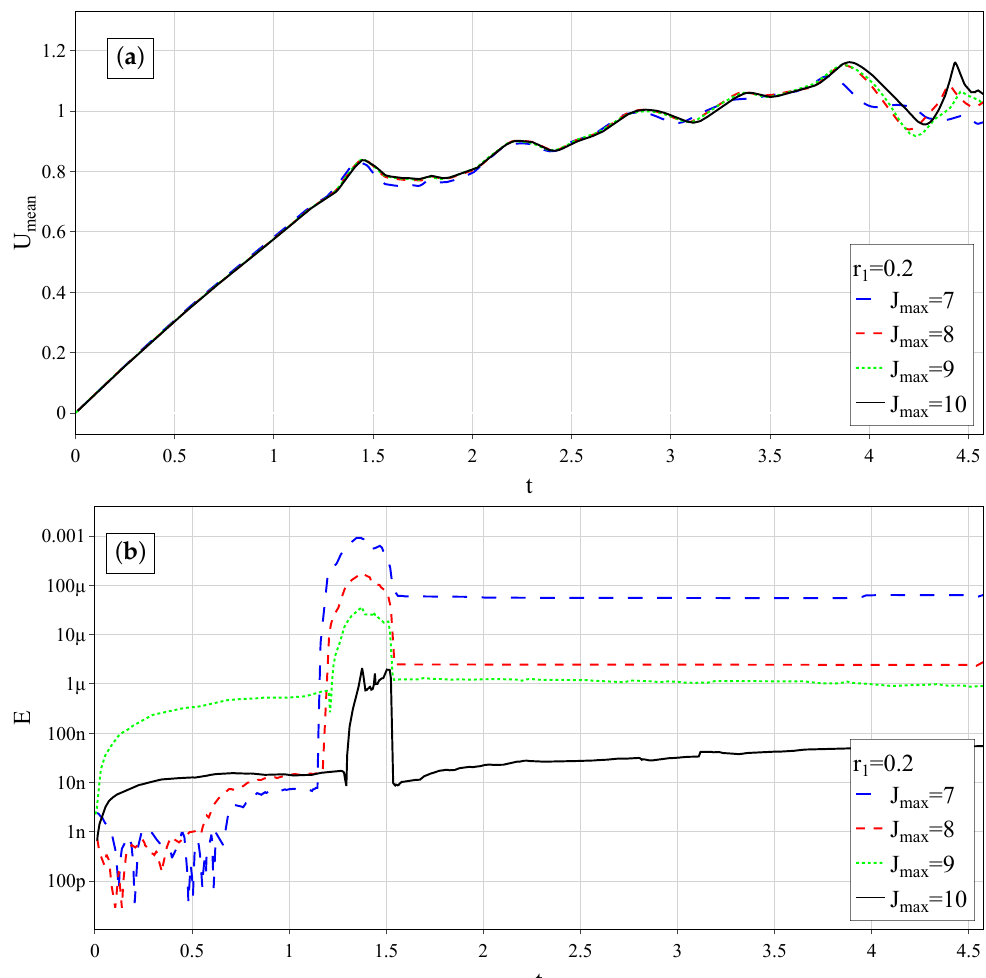
Figure 11. Convergence with the level of refinement for the case with a bubble of radius r 1 = 0.2. ( a ) The mean velocity in the domain, U mean , as a function of time for different maximum levels of refinement. ( b ) The relative error E =